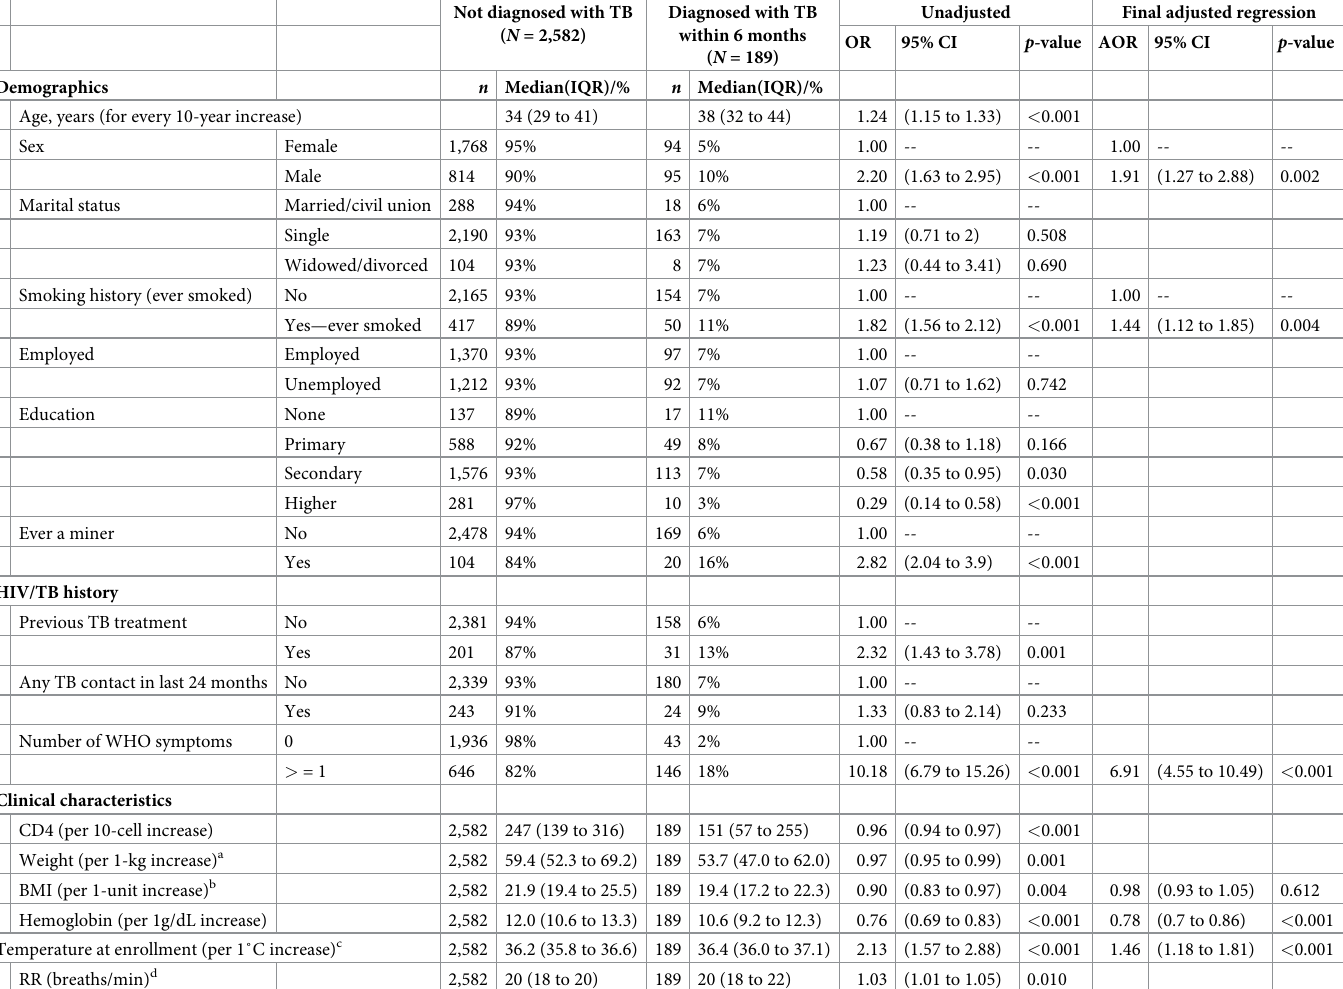
Table 2. Univariable and multivariable logistic regression analysis in the derivation dataset ( N =